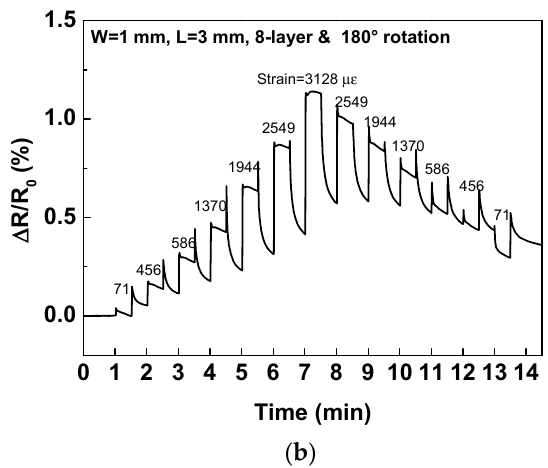
Figure 10. Stretch / release transient response as a function of various strains from 71 to 3128 µε for Figure 10. Stretch/release transient response as a function of various strains from 71 to 3128 µ ε for eight-layer strain sensor with ( a ) unidirectional printing; ( b ) 180 ◦ rotation. eight-layer strain sensor with ( a ) unidirectional printing; ( b ) 180° rotation.